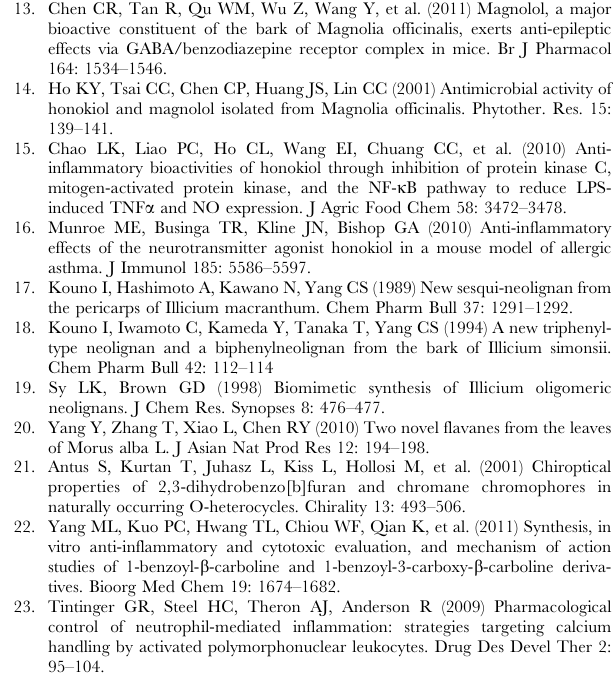
Figure S29 Mass Spectrum of Houpulin C (3). (TIFF) Figure S30 High Resolution Mass Spectrum of Houpu- lin C (3). (TIFF) Figure S31 1 H NMR Spectrum of Houpulin D (4). (TIFF) Figure S32 13 C and DEPT135 Spectra of Houpulin D (4). (TIFF) Figure S33 COSY Spectrum of Houpulin D (4). (TIFF) Figure S34 NOESY Spectrum of Houpulin D (4). (TIFF) Figure S35 HSQC Spectrum of Houpulin D (4). (TIFF) Figure S36 IR Spectrum of Houpulin D (4). (TIFF)